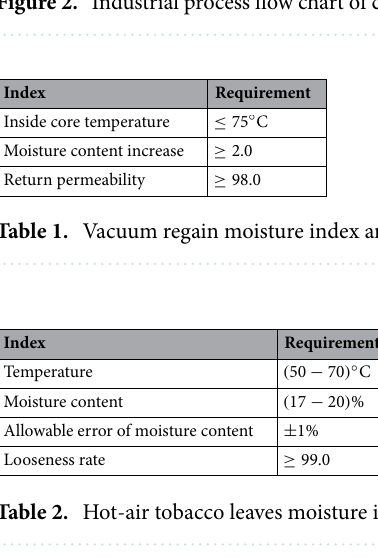
Figure 2. Industrial process flow chart of cigarette production.